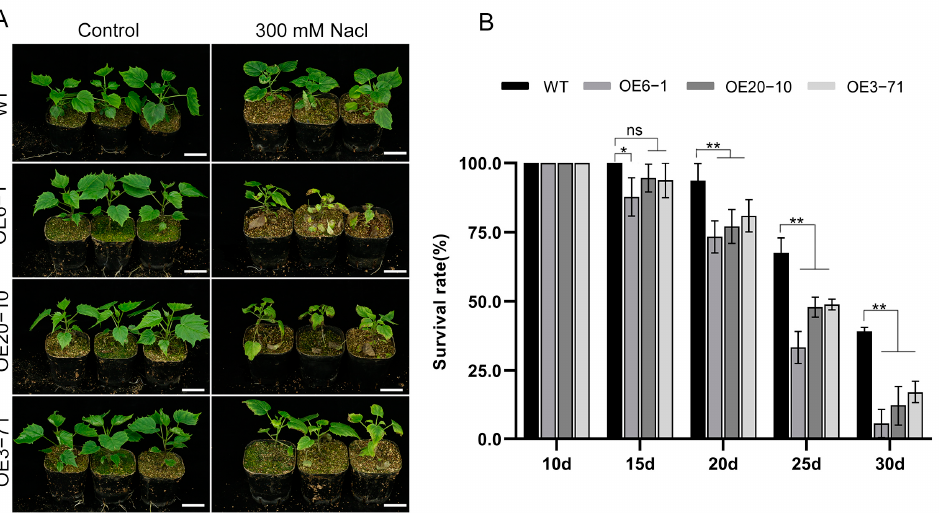
Figure 3. Overexpression of CbWRKY27 reduces survival rate in transgenic plants under salt treat- ment. ( A ) Phenotypic comparison of wild type (WT) and overexpression plants after 15 days under salt stress (300 mM NaCl). ( B ) Survival rates of overexpression plants and WT at 10, 15, 20, 25, and 30 days after continuous salt stress. Bar = 4 cm. The data represent the means ± SD ( n = 5), * p < 0.05 and ** p < 0.01 using Student’s t -test.